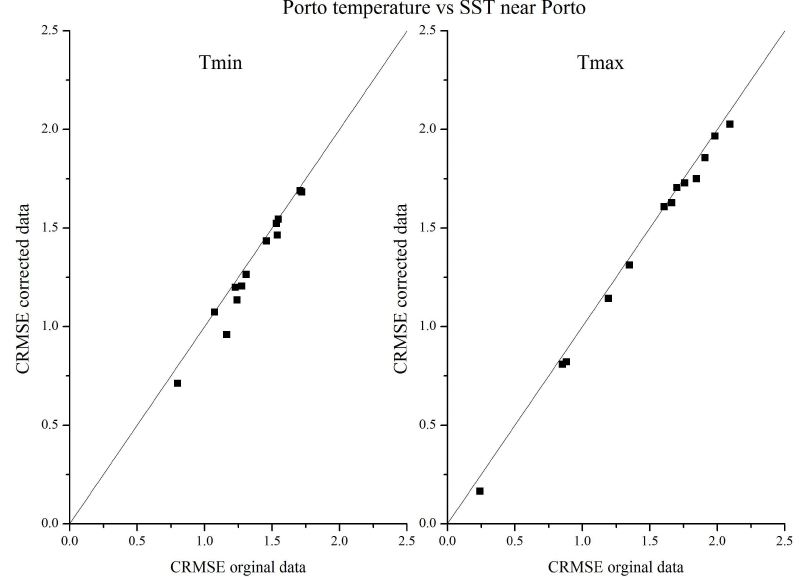
Figure 10. Porto: scatter plots of CRMSE before and after homogenization of 12 monthly and the annual series for T min (left) and T max (right). SST Porto anomalies data are used as reference series. Dots on or below the bisect indicate data sets with unchanged or improved (increased) homogeneity, while dots above the bisect indicate data sets with increased